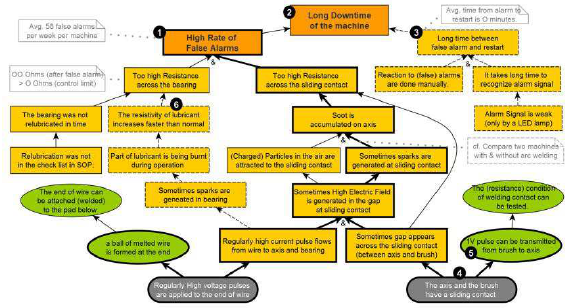
Figure 2. Part of a Cause-Effect Chain Analysis Plus carried out for a project [30]